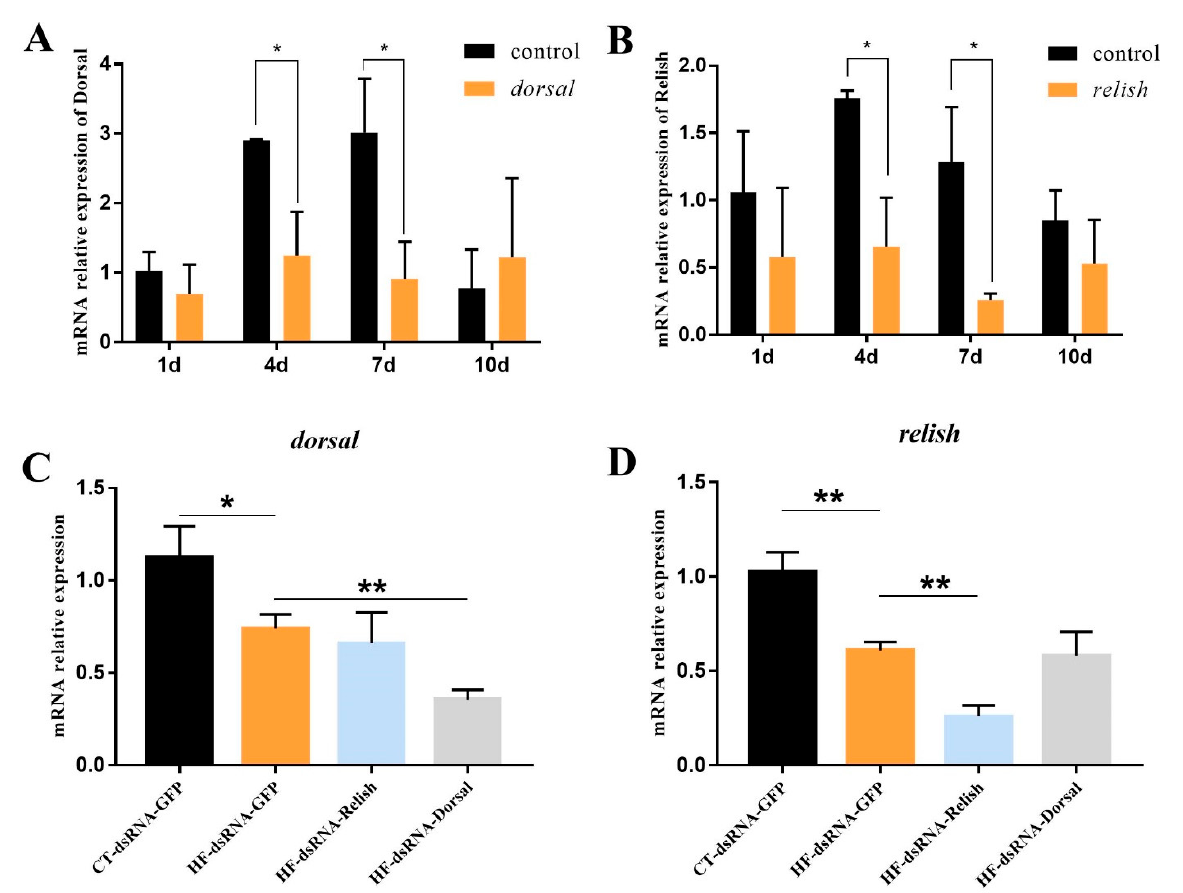
Figure 8. Knock-down of relish and dorsal in vivo expression by dsRNA-mediated RNA interference. ( A ) Time-course study of dorsal expression in hepatopancreas after RNA interference; ( B ) Time- course study of relish expression in hepatopancreas after RNA interference; ( C ) dorsal expression in M. rosenbergii fed with high-fat diet after RNA interference; ( D ) relish expression in M. rosenbergii fed with high-fat diet after RNA interference. Values are means ± SEM. **: p < 0.01, *: p < 0.05.